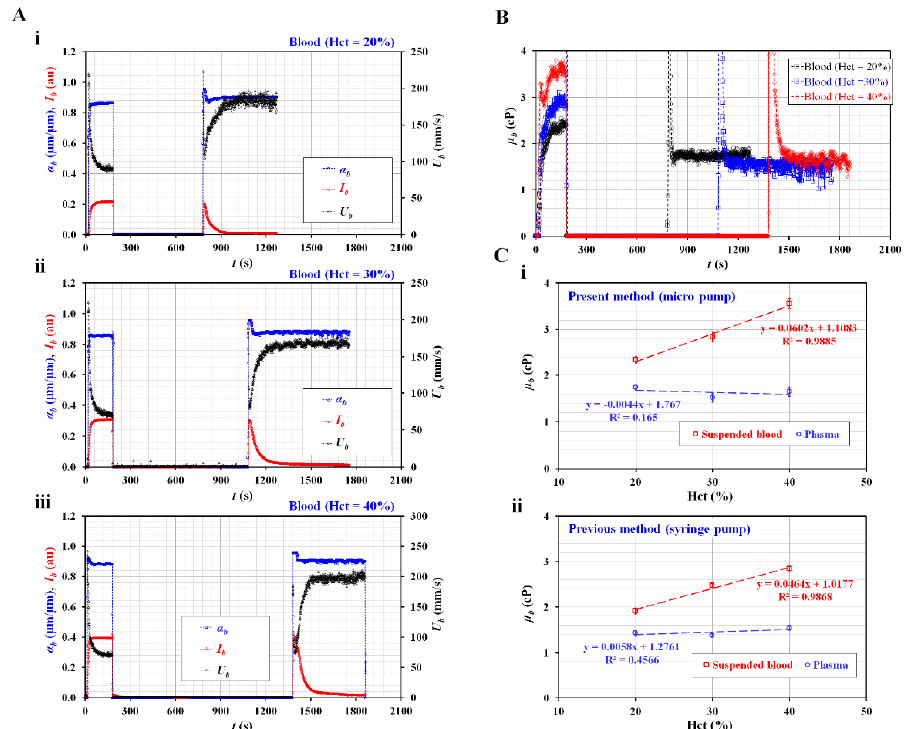
Figure 4. Sequential viscosity measurement of suspended blood and plasma with respect to Hct. ( A ) Temporal variations of α b , I b , and U b with respect to Hct = 20%, 30%, and 40%. ( B ) Temporal variations of μ b with respect to Hct. ( C ) Quantitative comparison between the present method (i.e., blood delivery with micro pump) and previous method (i.e., blood delivery with syringe pump). (i) Steady viscosity value of blood and plasma obtained using the present method with respect to Hct.